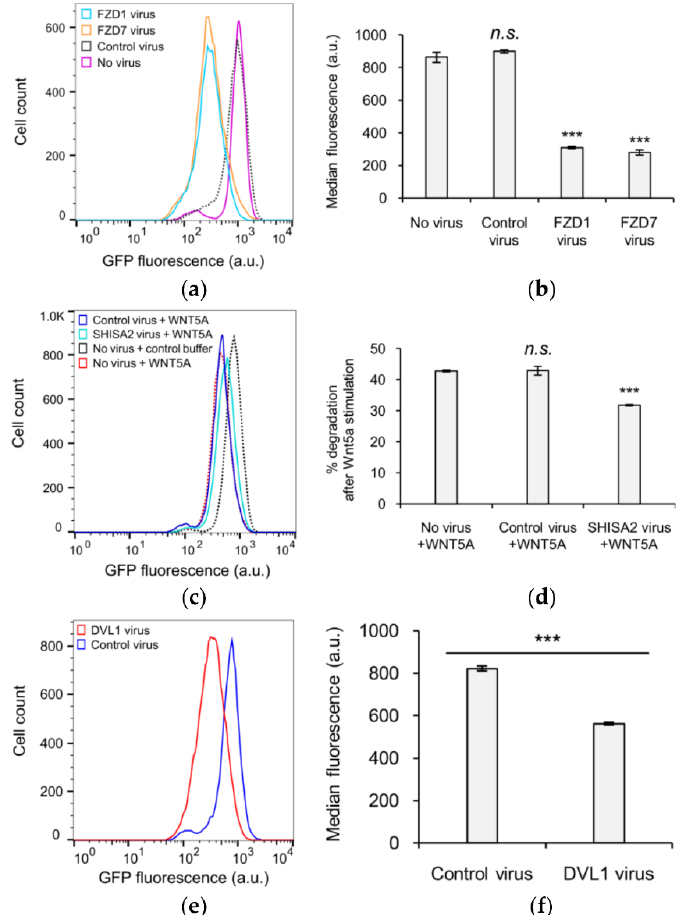
Figure 3. Functional characterization of KIF26B-C in the degradation reporter assay. ( a ) Flow cytometry histograms depicting the effect of ectopic FZD1 and FZD7 expression on GFP-KIF26B-C degradation (a.u. = arbitrary units); ( b ) Quantification of ( a ) (a.u. = arbitrary units). Median fluorescence is used for quantification because the experiment involved direct comparison of different cell lines, unlike the experiments presented in previous figures where % degradation was used to specifically express the effects of WNT5A stimulation within the same cell lines. Error bars represent ± SEM calculated from three independent replicates of each experimental condition. Statistical analysis was performed with unpaired t -test ( n.s. = not significant; *** p value < 0.001 vs. no virus); ( c ) Flow cytometry histograms depicting the effect of ectopic SHISA2 expression on GFP-KIF26B-C degradation (a.u. = arbitrary units). Control buffer traces for “Control virus” and “SHISA2 virus” lines are similar to that of the “No virus” and thus not shown for visual clarity. However, data from the respective buffer control experiment for each virus-infected line were used for the quantification shown in ( d ); ( d ) Quantification of ( c ). Error bars represent ± SEM calculated from three independent replicates of each experimental condition. Statistical analysis was performed with unpaired t -test ( n.s. = not significant; *** p value < 0.001 vs. no virus, +WNT5A); ( e ) Flow cytometry histograms depicting the effect of ectopic DVL1 expression on GFP-KIF26B-C degradation (a.u. = arbitrary units); ( f ) Quantification of ( e ) (a.u. = arbitrary units). Error bars represent ± SEM calculated from three independent replicates of each experimental condition. Statistical analysis was performed with unpaired t -test (*** p value < 0.001 vs. control